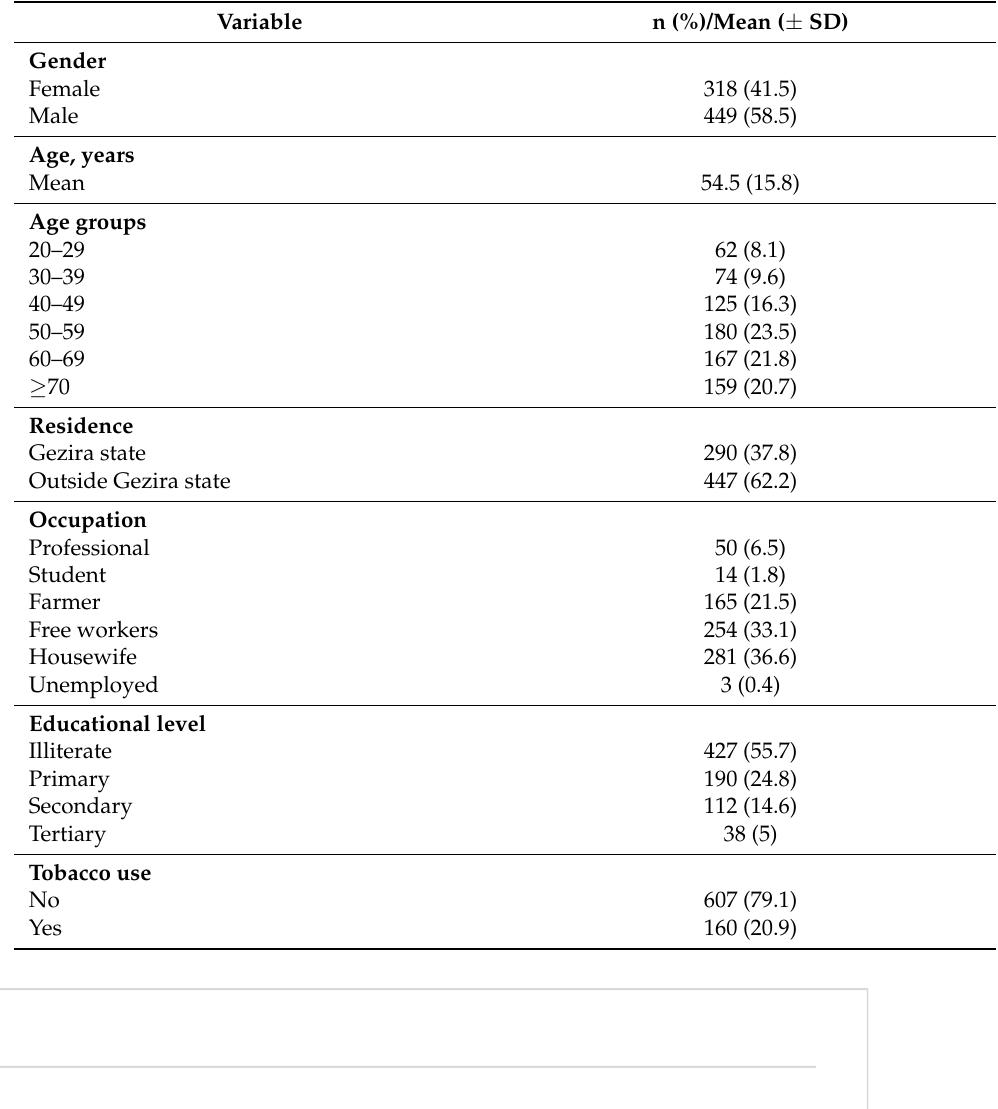
Table 1. Characteristics of study participants, n = 767.